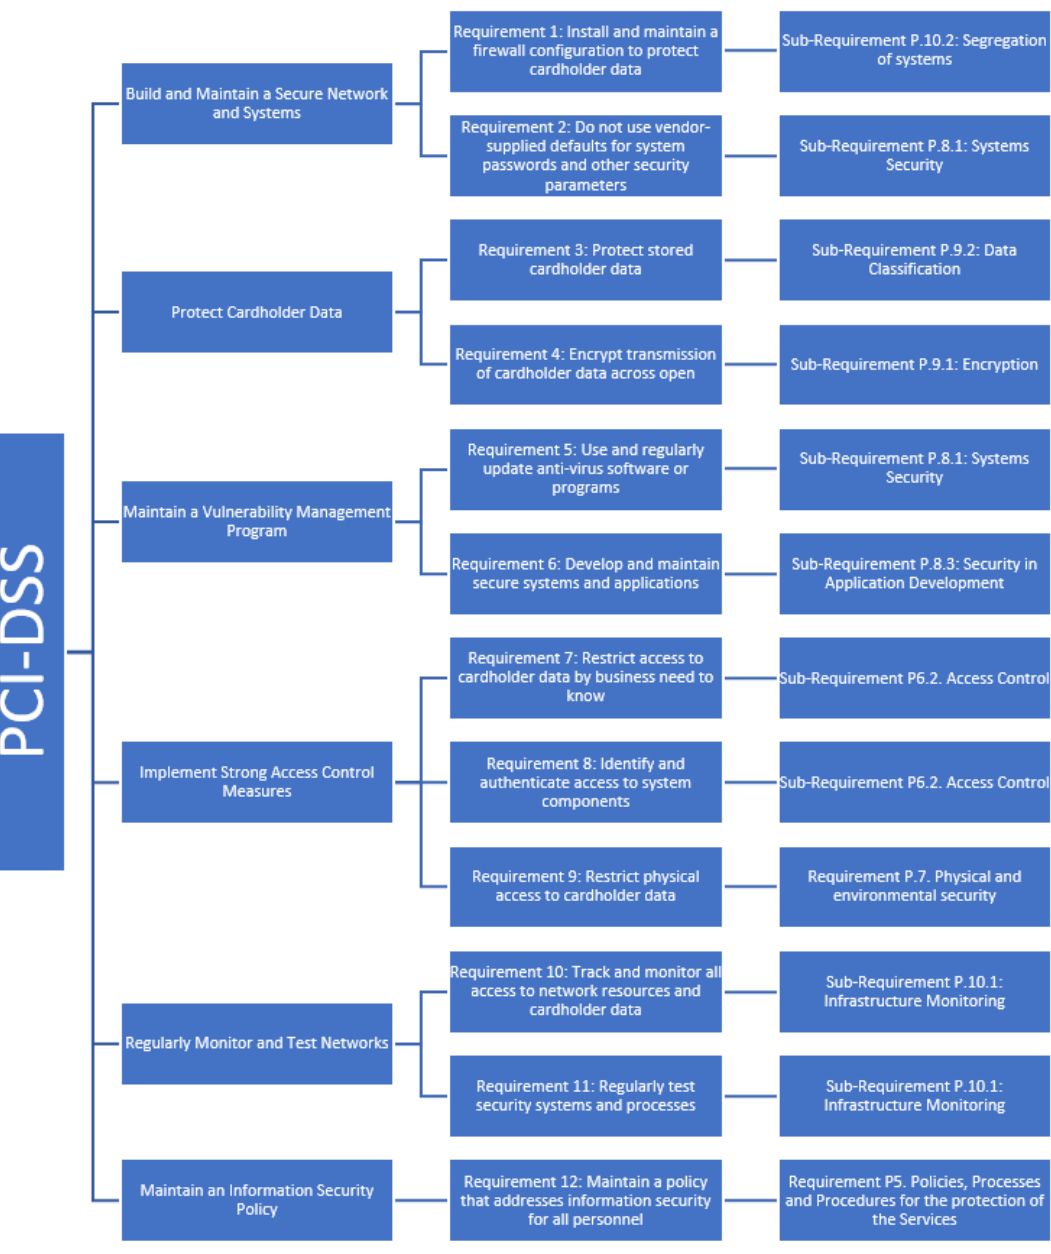
Figure 4. Payment Card Industry Data Security Standard (PCI DSS)